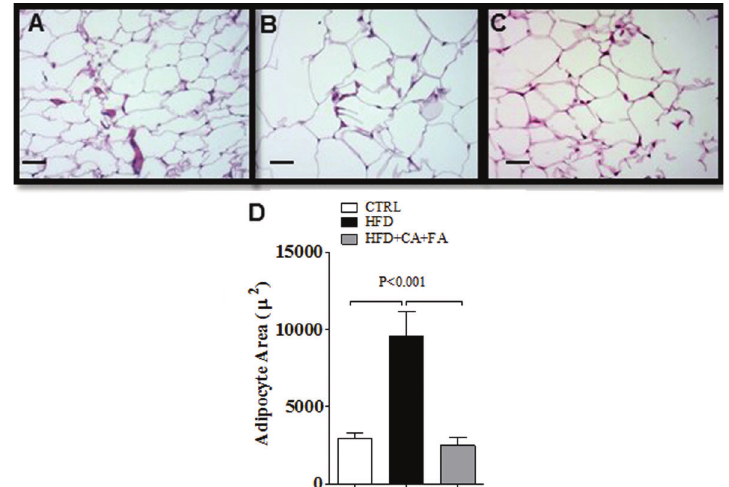
Figure 4. Effect of a high-fat diet (HFD) with combined treatment of caffeic acid (CA) and ferulic acid (FA) (0.9 and 50 mg (cid:3) kg – 1 (cid:3) day – 1 , respectively) on histology of epididymal white adipose tissue. A, Control (CTRL) mice; B , HFD treated mice; C , HFD + CA + FA treated mice. All magni fi cations are (cid:1) 200. Scale bar: 50 m m. D , Estimated individual epididymal adipocyte area; 40 cells for each animal ( fi ve animals per group) were analyzed. ANOVA followed by the Student Newman-Keuls test were used for statistical analyses.